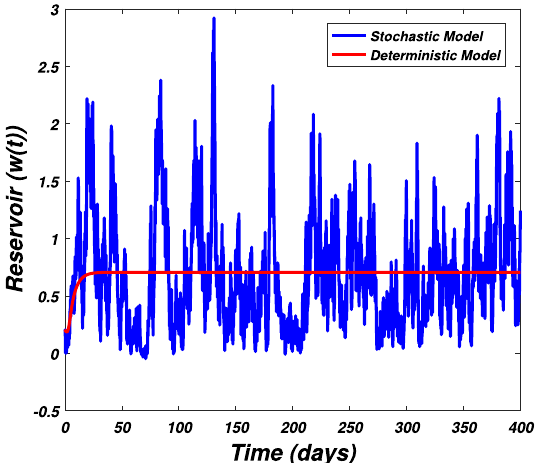
Figure 13. The graph visualizes the large scale numerical simulation of the reservoir class ( w ( t )) of the model reported by Eq. (1) against parameters value S 2 and (0.5, 0.3, 0.2,